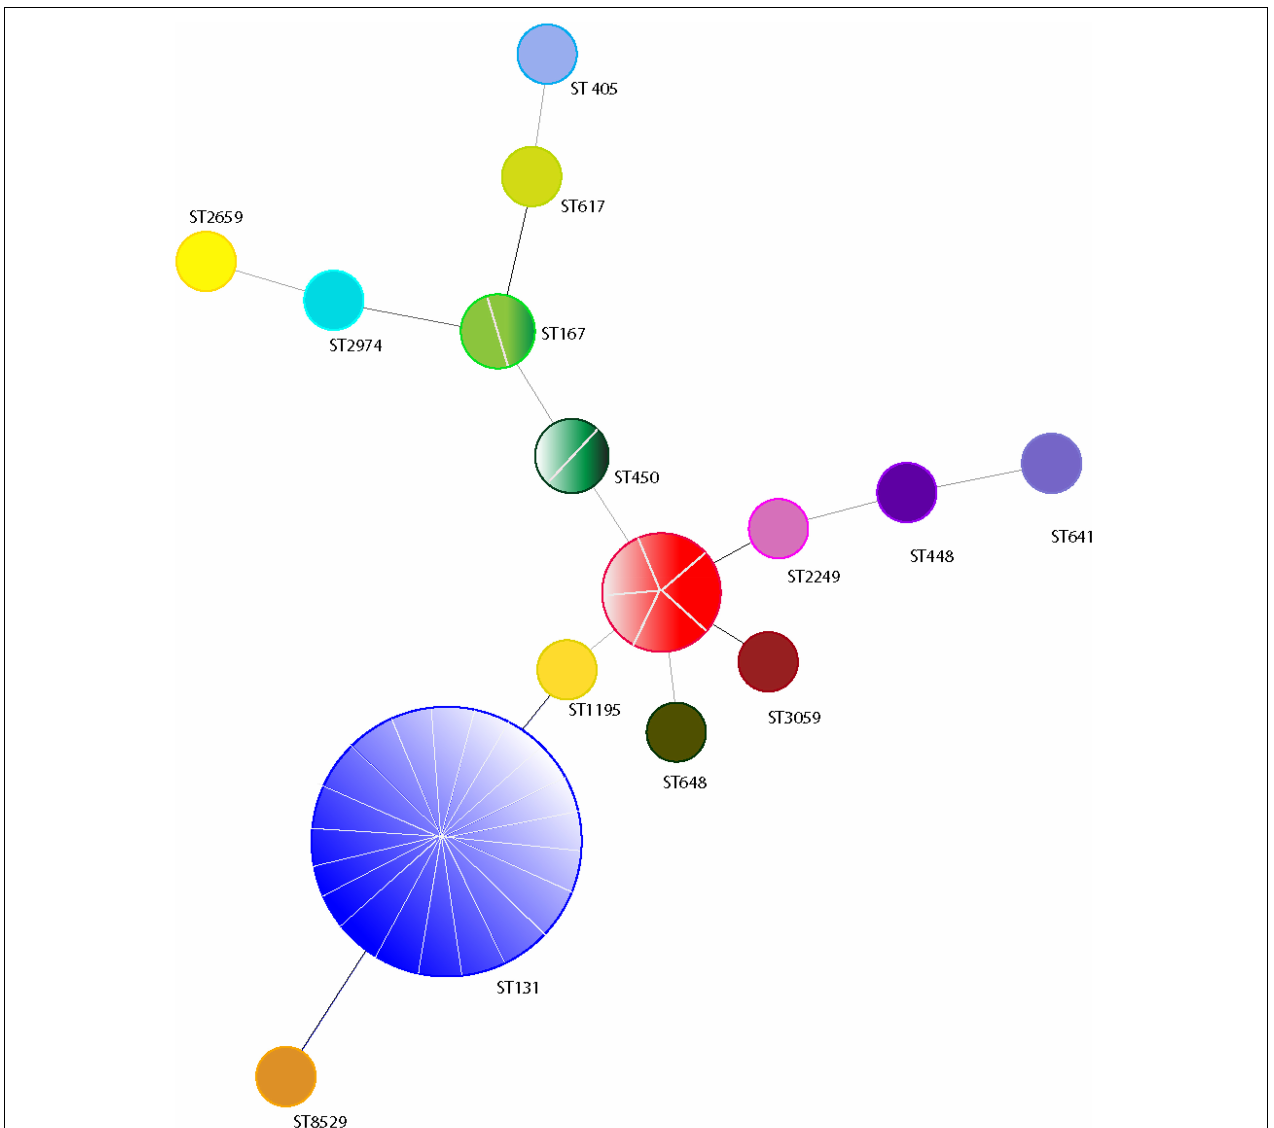
FIGURE 4 | eBURST analysis of minimum spanning tree of 40 ESBL positive E. coli isolates based on MLST genotypes. The genotypes represented by a circle and the line between each circle represents individual isolates. The line within a circle indicates the number of isolates belong to the genotype.